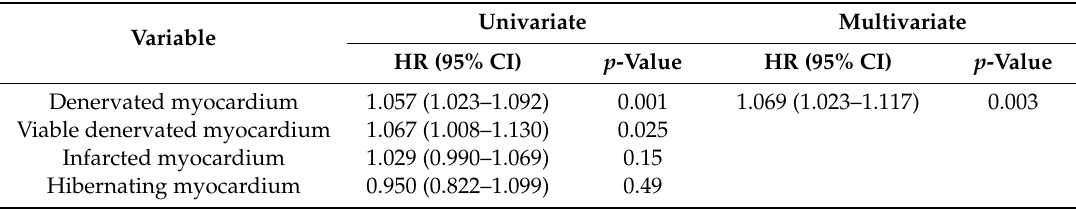
Table 1. Significant predictors of time to SCA.